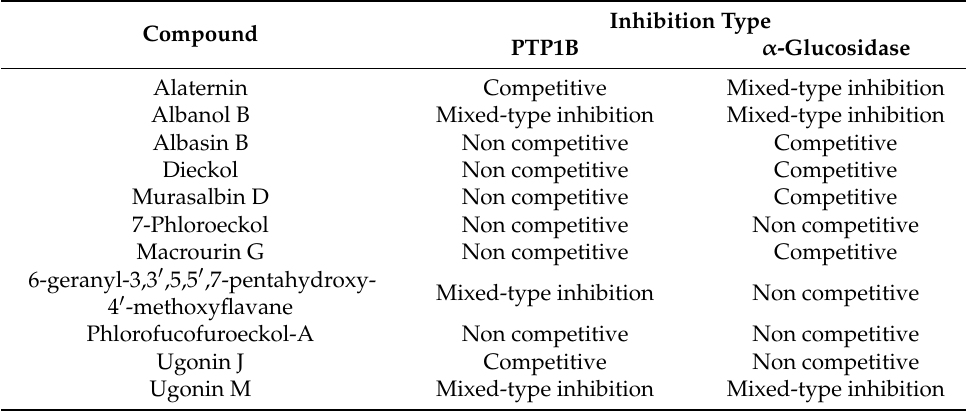
Inhibition Type PTP1B α -Glucosidase